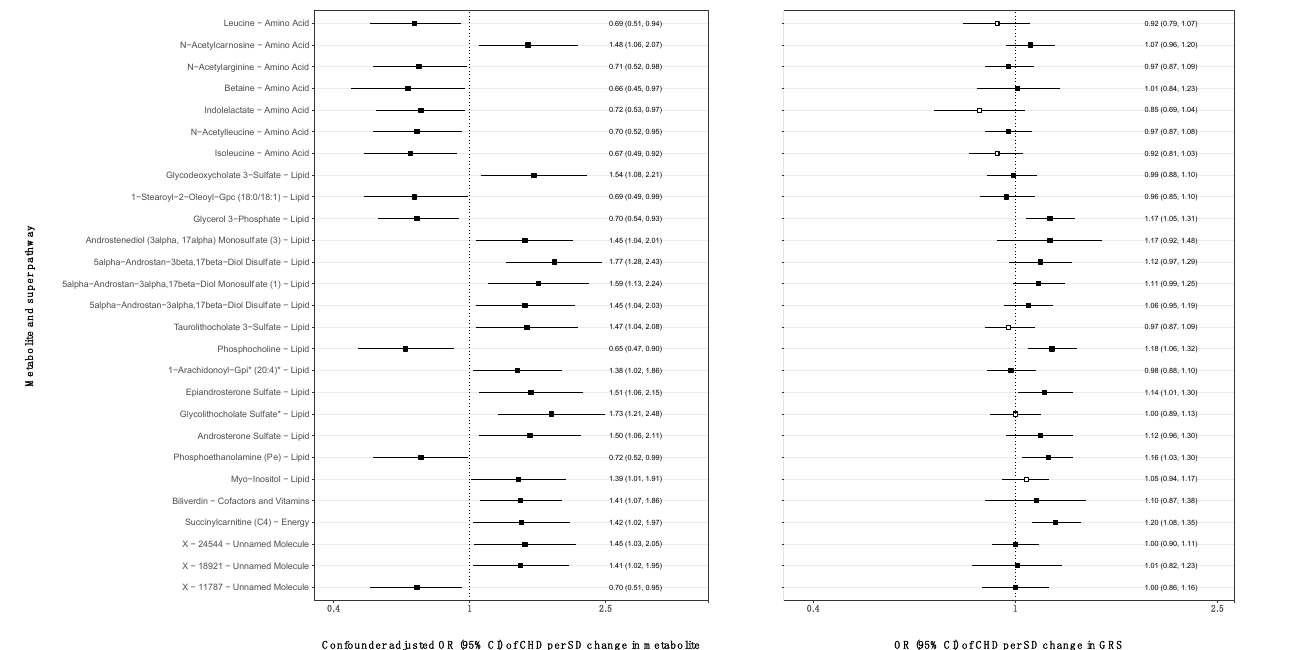
Figure 3. Exploring directional consistency between phenotype (conventional multivariable regression) and genotype (Mendelian randomization) associations with metabolites. Showing results comparing the main confounder adjusted associations of maternal metabolites with offspring CHDs (Panel A: N = 2391 and N CHD cases = 42 in the Born in Bradford cohort) to the Mendelian randomization analyses of maternal genetic risk scores and offspring CHDs (Panel B: N = 38,662 and N CHD cases = 319 across 3 cohorts). N.B., results from each analysis are presented on different scales; we are not attempting to quantify estimates in the MR analyses, the aim is to compare the direction of effect. The confounder adjusted associations are as above in Figure 2. The MR analyses are adjusted for the top 10 genetic principal components and genetic batches in MoBa. In Panel B, the metabolite genetic risk scores filled with white appeared to be non-specific for the metabolite we were trying to instrument (i.e., the risk score relates to several other metabolites more strongly than the specific named metabolite). The metabolites filled in black were either metabolite-specific or specific to the metabolite and other correlated metabolites (see scatter plots in Figure S4). The results were pooled using random effects meta-analyses; individual study results and p -values for heterogeneity are shown in Supplementary Table S8. * at the end of metabolite names as defined by Metabolon. Abbreviations: BiB, Born in Bradford; CHD, congenital heart disease; GRS, genetic risk score; MR, Mendelian randomization; OR, odds ratio; CI, confidence